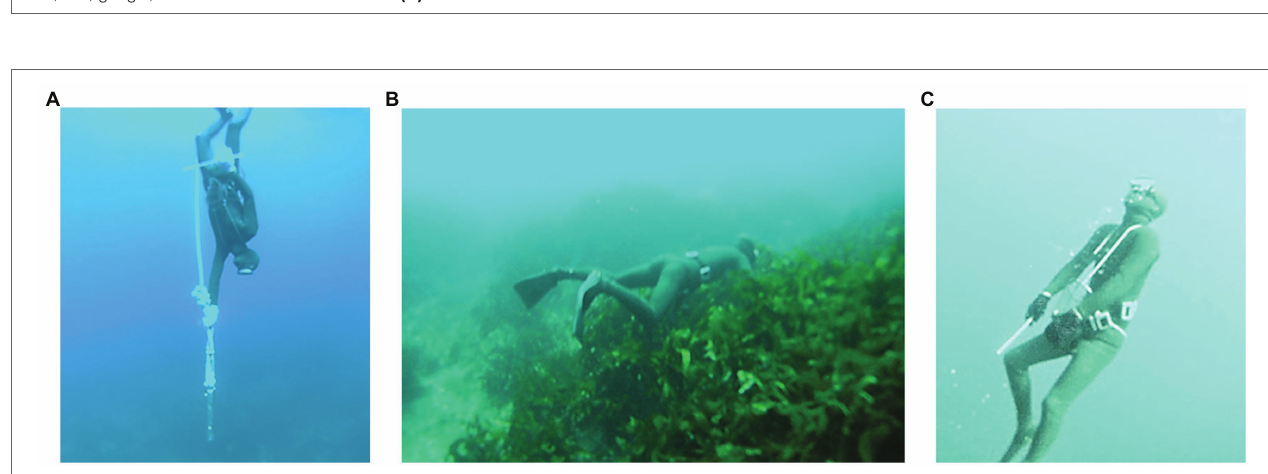
FIGURE 1 | An assisted male Ama diver, called Funado needs his partner (generally, wife) to operate fishing boat, which has a rolling machine to pull up his weight and a basket for seafoods (A) . His wife on the boat pulls up an iron-weight and gets closer to Ama after each his dive (B) . Ama’s diving equipment includes weight belt, fins, goagle, and hook and net for sea foods (C)